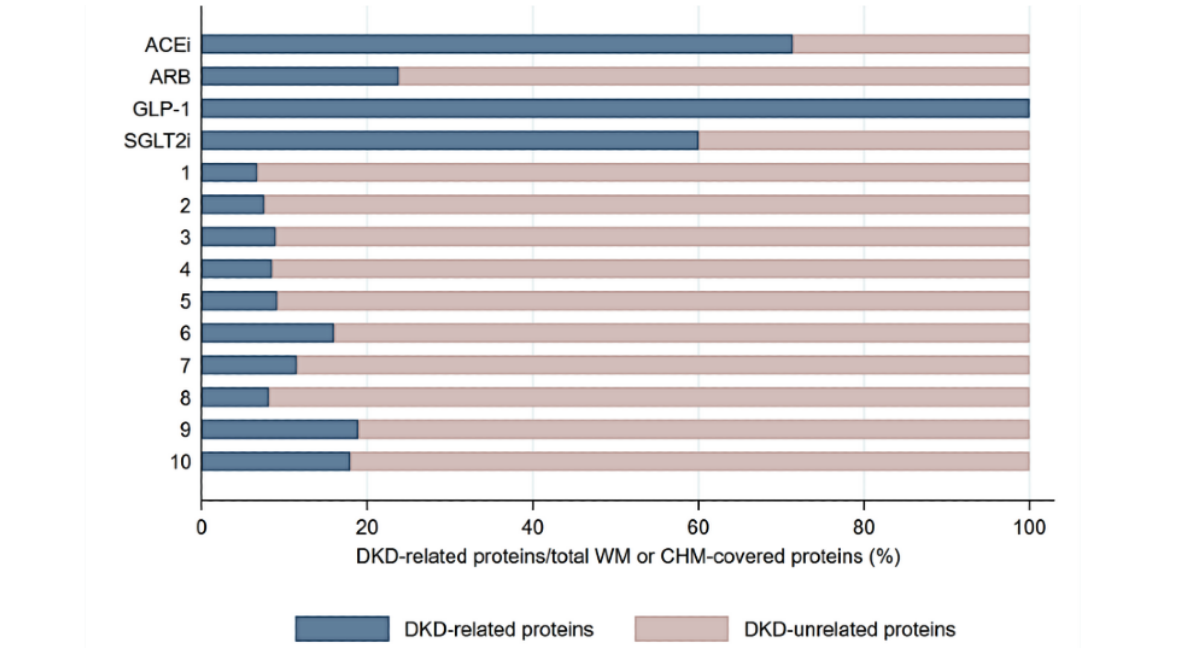
Figure 6. The proportion of proteins covered by CHM or WM specific to DKD. WM aimed more specifically at DKD-related proteins. ACEi: angiotensin-converting enzyme inhibitor; ARB: angiotensin receptor blocker; CHM: Chinese herbal medicine; DKD: diabetic kidney disease;